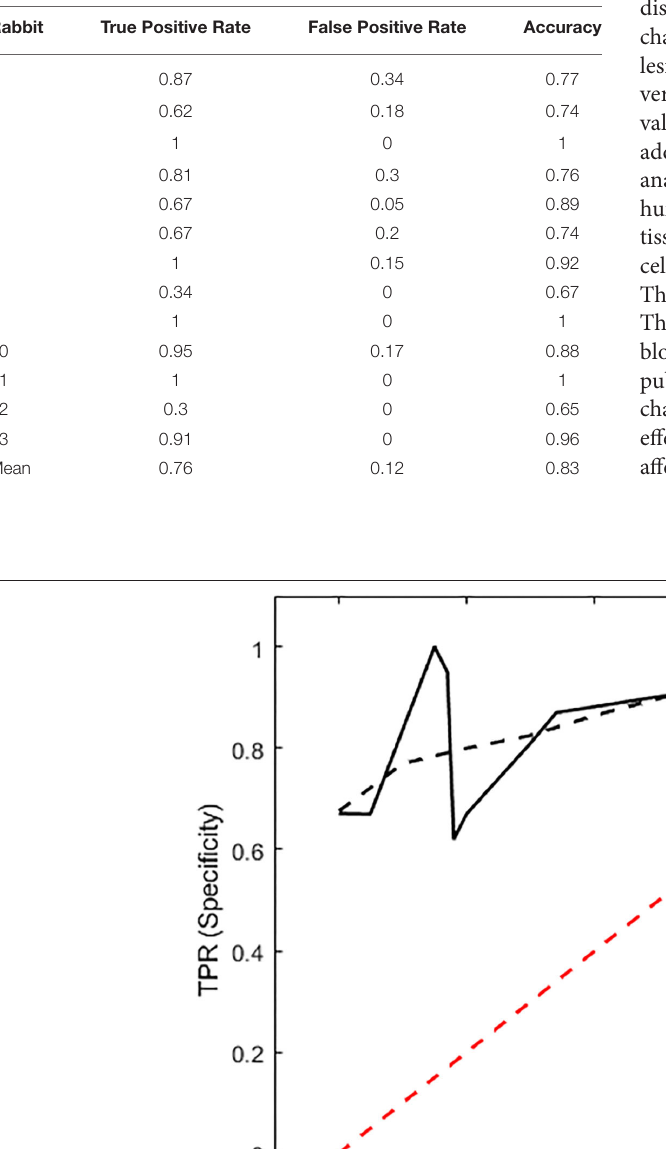
TABLE 2 | ROC analyses. TPR, FPR, and accuracy are reported for each rabbit.